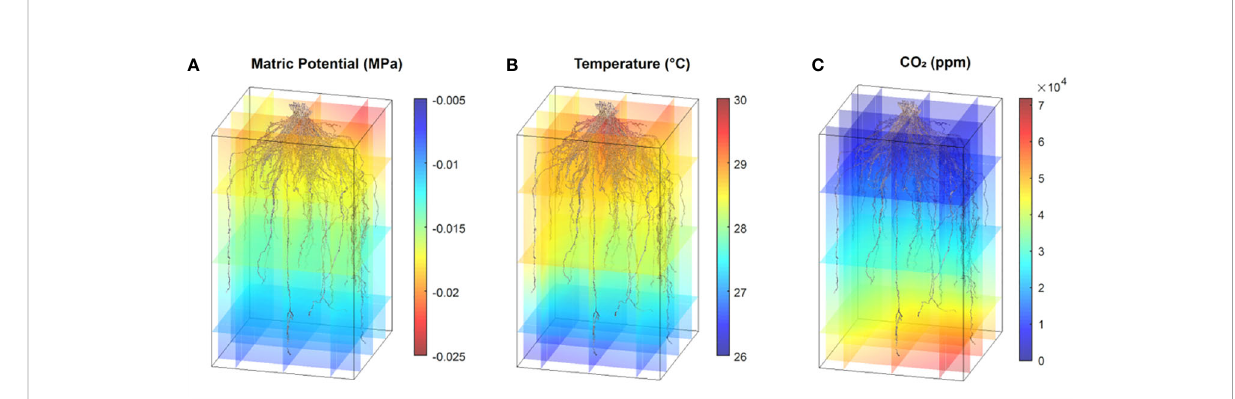
FIGURE 12 Point cloud RSA models and environmental data synthesis. Data shows one switchgrass point cloud with coaligned environmental 3D data for matric potential (A) , temperature (B) and CO 2 levels (C) . All data are from the same time point collected between 11 am and 1